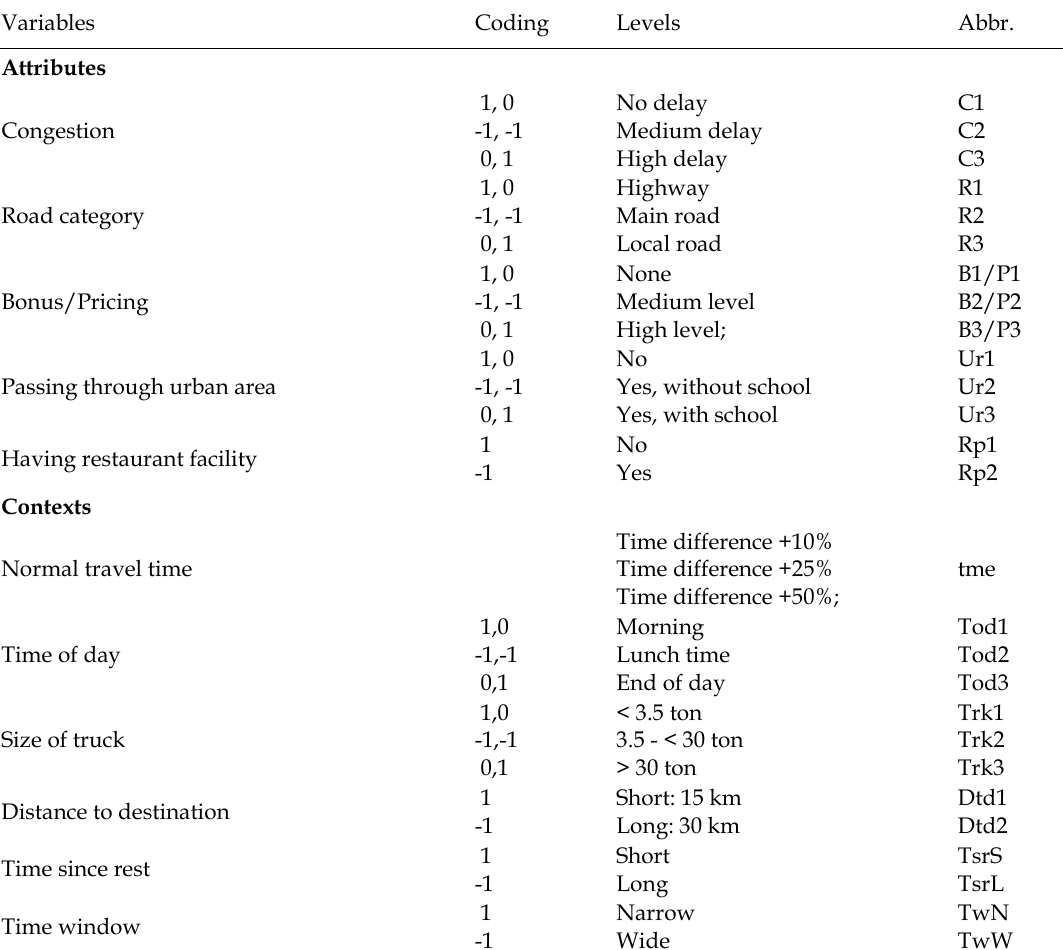
Table 1 Attributes and levels used in the stated choice experiment (source: Arentze et al. 2012) Variables Coding Levels